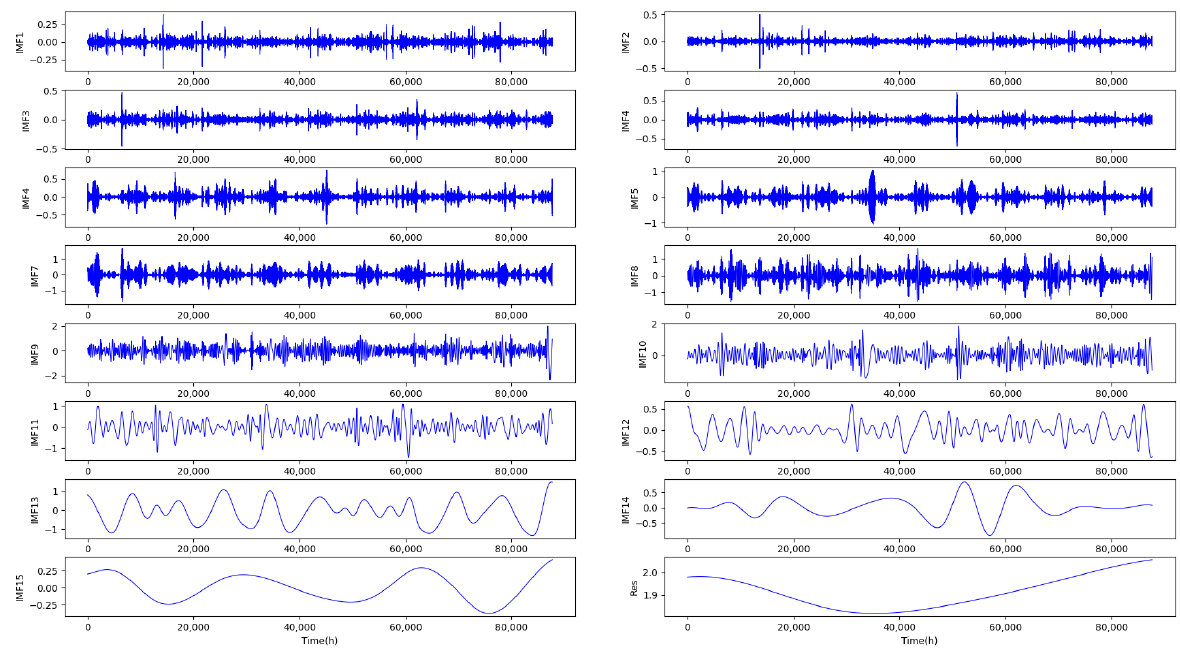
Figure 12. The EMD method was used to decompose the significant wave height results at posi- tion